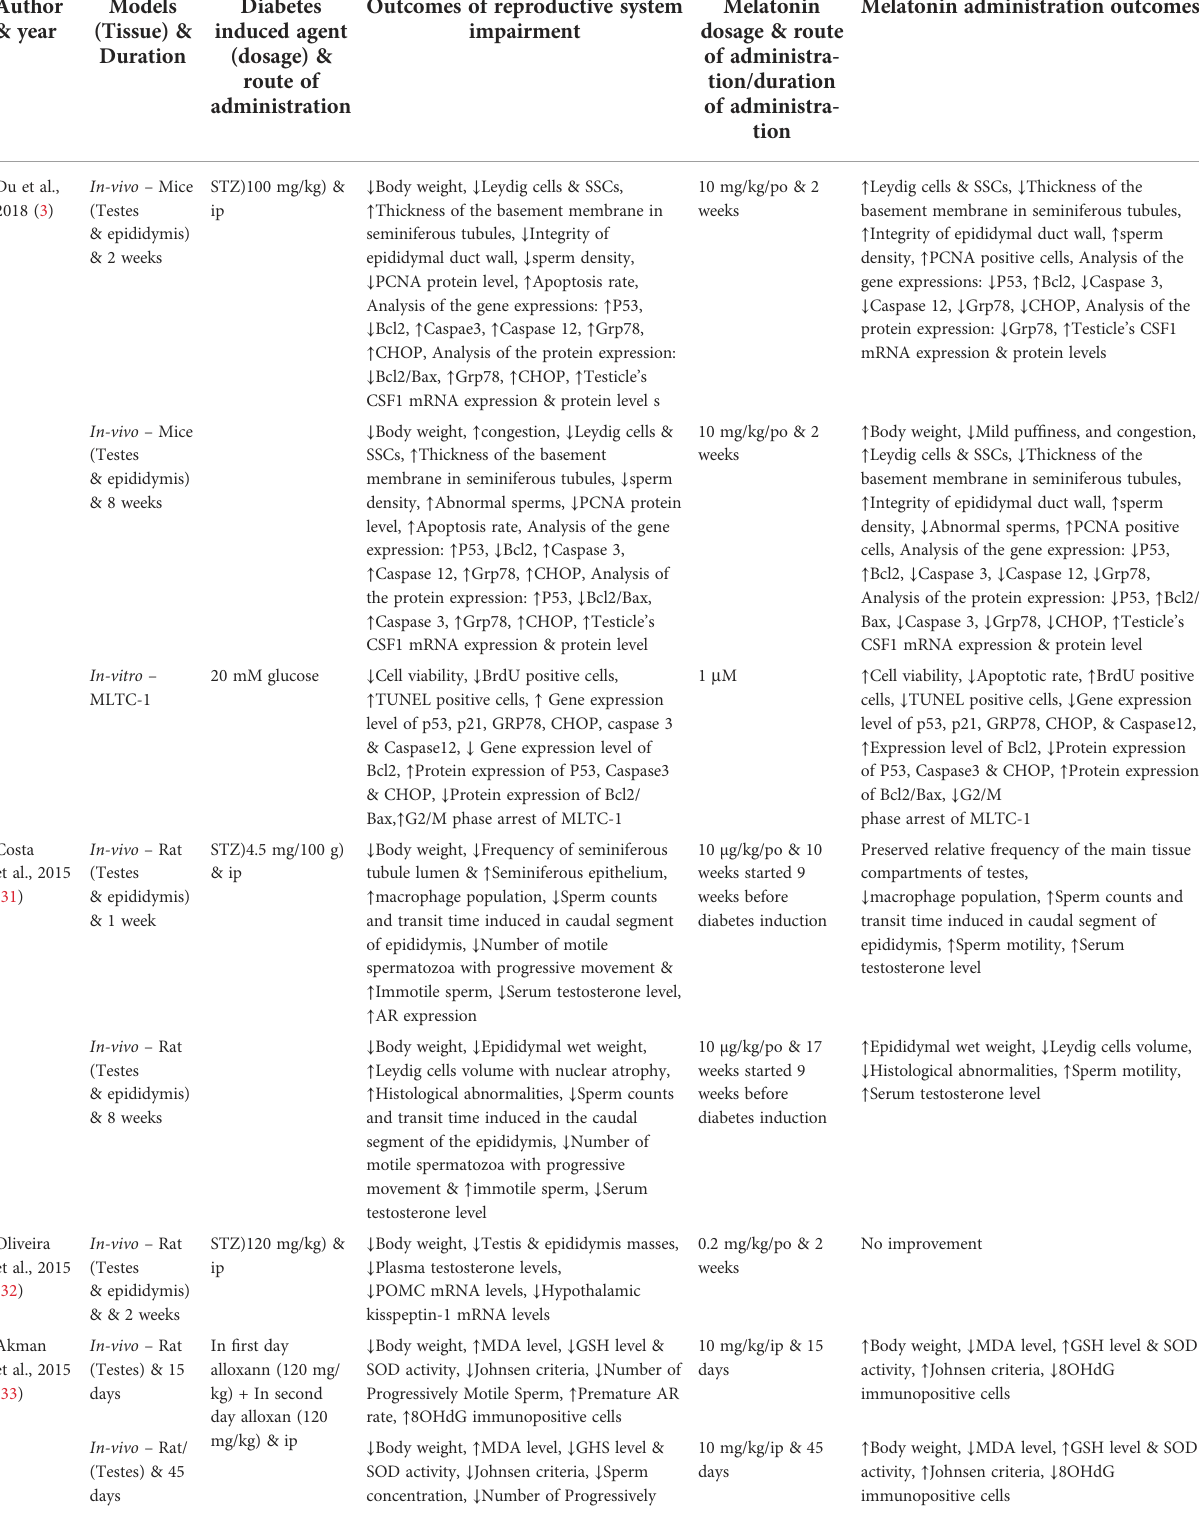
TABLE 1 The summary of in-vivo and in-vitro studies in systematic literature